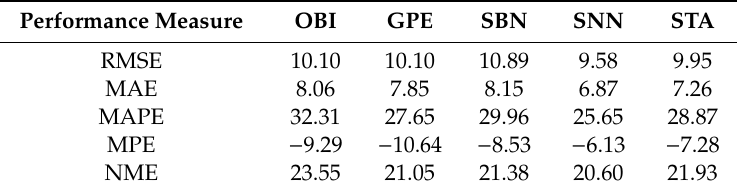
Table 10. Performance measures for the models at each site. The measures were computed with the original scale.